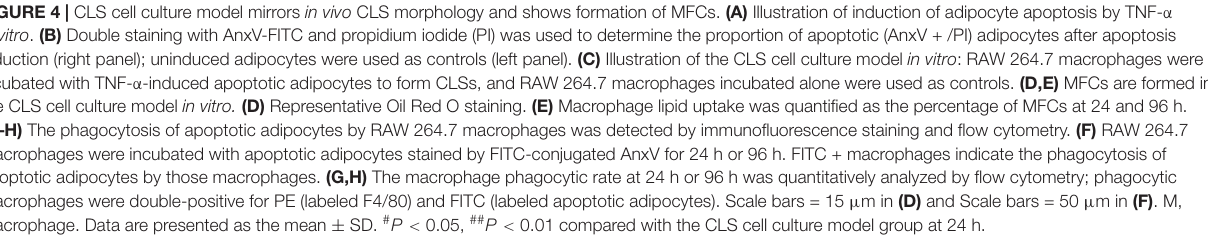
FIGURE 4 | CLS cell culture model mirrors in vivo CLS morphology and shows formation of MFCs. (A) Illustration of induction of adipocyte apoptosis by TNF- α in vitro . (B) Double staining with AnxV-FITC and propidium iodide (PI) was used to determine the proportion of apoptotic (AnxV + /PI) adipocytes after apoptosis induction (right panel); uninduced adipocytes were used as controls (left panel). (C) Illustration of the CLS cell culture model in vitro : RAW 264.7 macrophages were incubated with TNF- α -induced apoptotic adipocytes to form CLSs, and RAW 264.7 macrophages incubated alone were used as controls. (D,E) MFCs are formed in the CLS cell culture model in vitro. (D) Representative Oil Red O staining. (E) Macrophage lipid uptake was quantified as the percentage of MFCs at 24 and 96 h. (F–H) The phagocytosis of apoptotic adipocytes by RAW 264.7 macrophages was detected by immunofluorescence staining and flow cytometry. (F) RAW 264.7 macrophages were incubated with apoptotic adipocytes stained by FITC-conjugated AnxV for 24 h or 96 h. FITC + macrophages indicate the phagocytosis of apoptotic adipocytes by those macrophages. (G,H) The macrophage phagocytic rate at 24 h or 96 h was quantitatively analyzed by flow cytometry; phagocytic macrophages were double-positive for PE (labeled F4/80) and FITC (labeled apoptotic adipocytes). Scale bars = 15 µ m in (D) and Scale bars = 50 µ m in (F) . M, macrophage. Data are presented as the mean ± SD. # P < 0.05, ## P < 0.01 compared with the CLS cell culture model group at 24